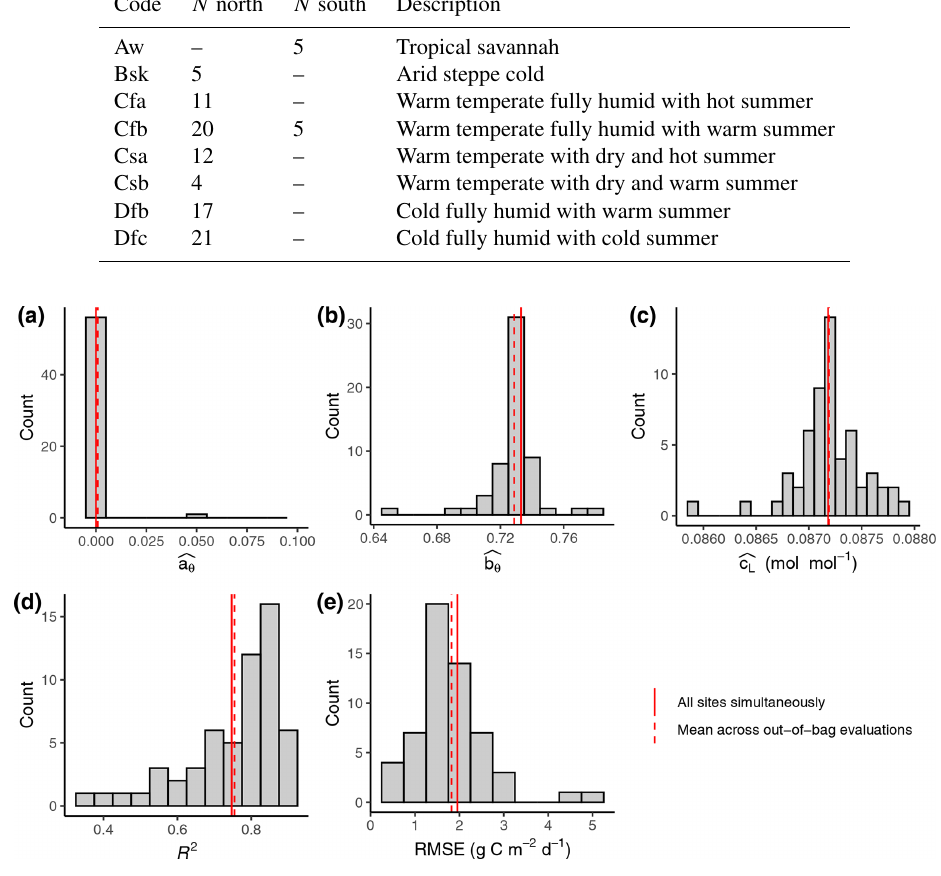
Figure 2. Out-of-sample calibration and evaluation results. (a–c) Distribution of parameter values (FULL setup) from calibrations where data from one site were left out for each individual calibration. Parameters (cid:98) a θ and (cid:98) b θ are unitless. (d, e) Distribution of evaluation metrics calculated on data from the left-out site based on simulations with model parameters calibrated on all other sites’ data. Solid vertical red lines represent the parameter values calibrated with data from all sites pooled. These are the values reported in Tables 3 and 4 for FULL setup. Dashed red lines represent the mean across values from out-of-bag calibrations and